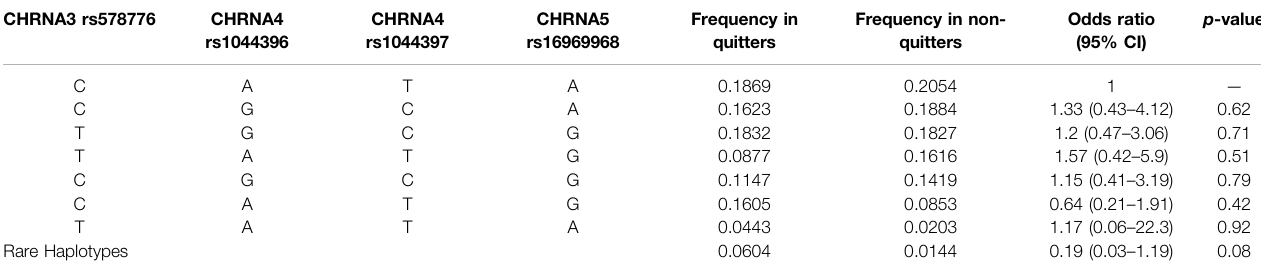
TABLE 5 | Estimated CHRNA haplotype frequencies among quitters and non-quitters and their association for quitting smoking. CHRNA3